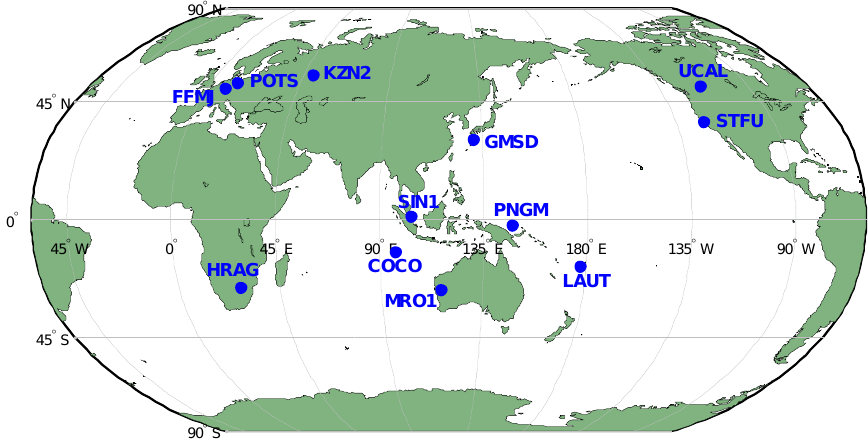
Figure 7. The distribution of the selected stations for the accuracy test experiment.